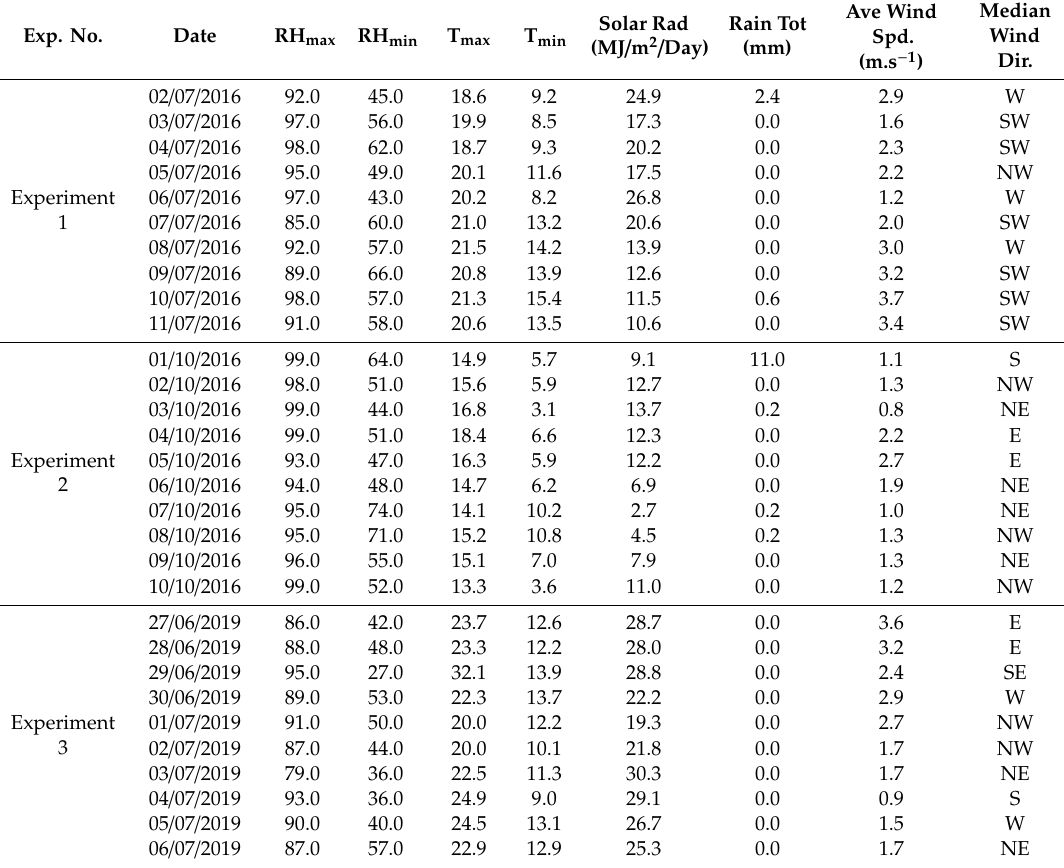
Table A1. Weather data for 10-day periods prior to each experimental sampling date. Exp.